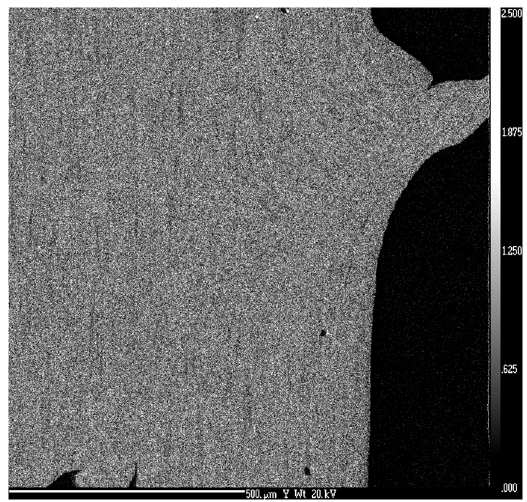
Figure 12. WDS yttrium distribution for a weld within the working area with the selected parameters ( F w ; I w ; t w ; C s ) = (2400 N; 14 kA; 15 ms; 0.2 mm).